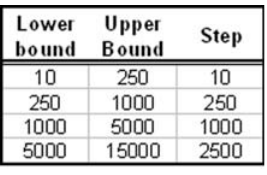
Table 1. Number N of data (size of sample) drawn randomly from the reference PDF for all experiments.